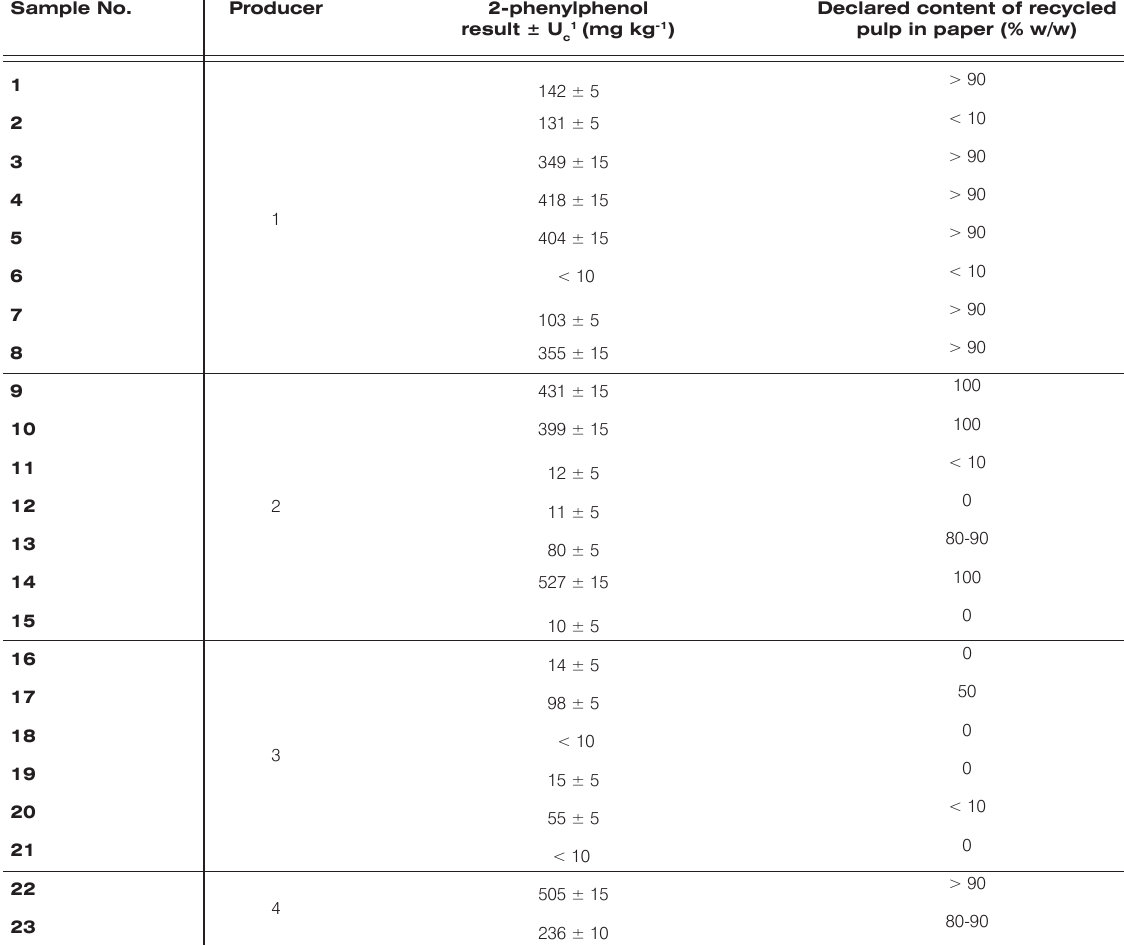
Table 2. Content of 2-phenylphenol in samples of paper materials used for food packaging in the Czech Republic. Sample